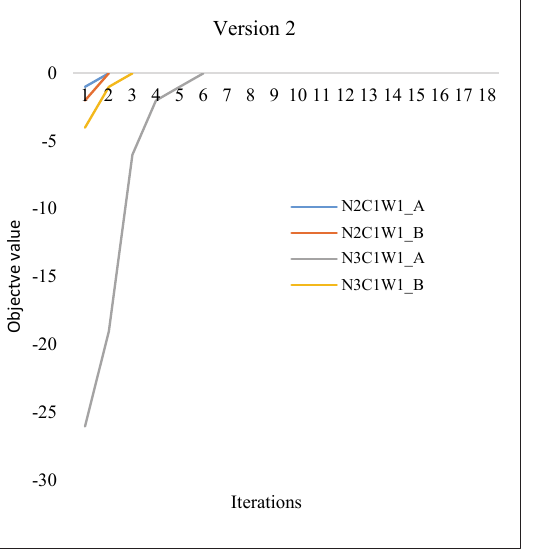
Fig. 10. Performance of version 1 algorithm for sample datasets with 100 and 200